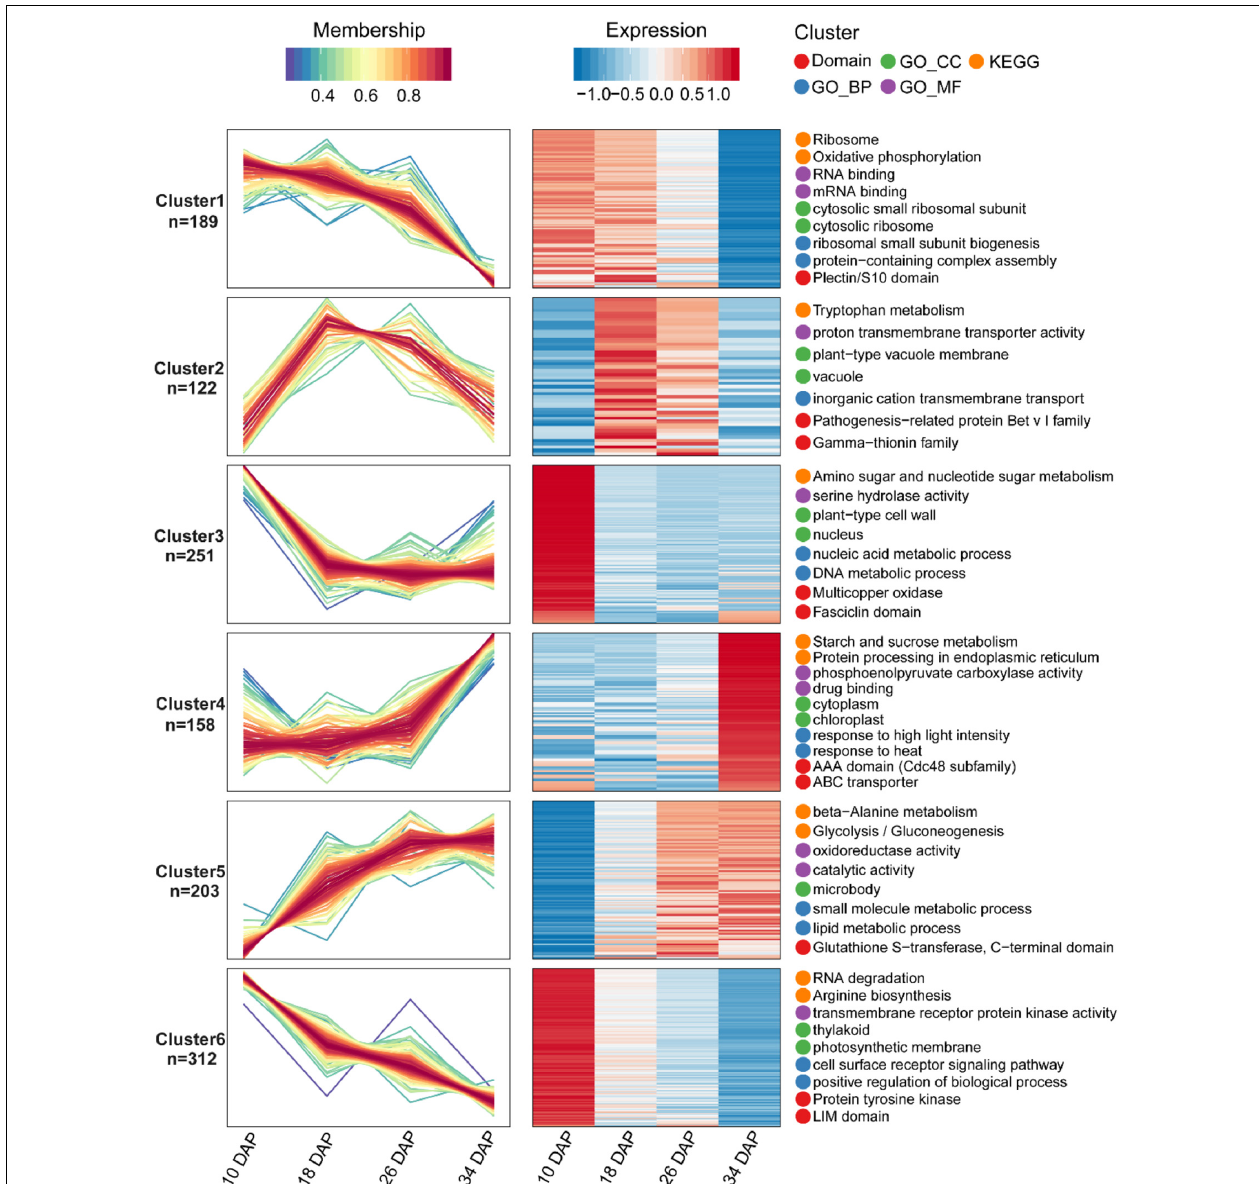
FIGURE 3 | Fuzzy c-means algorithm and enrichment analysis of DEPs. A total of 1,235 DEPs were divided into six clusters by the Fuzzy c-means algorithm, and the top two enriched items from GO/KEGG/Domain enrichment analysis were displayed on the right side of the corresponding